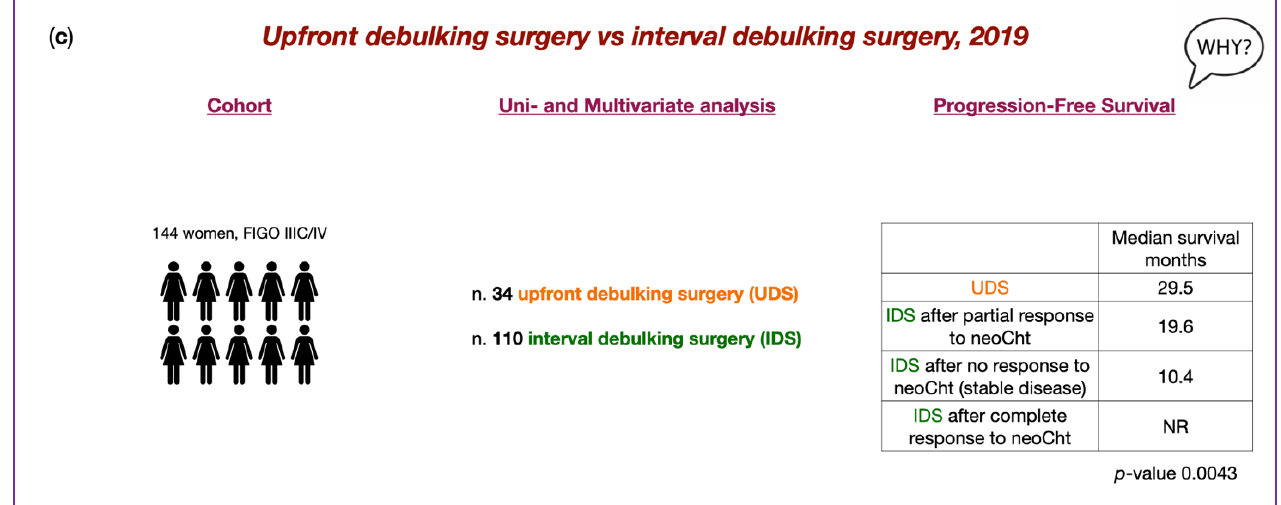
Figure 4. Italian PSM Oncoteam evidence. ( a ) Cavaliere et al. “1st Evidence− based Italian consensus conference on cytoreductive surgery and hyperthermic intraperitoneal chemotherapy for peritoneal carcinosis from ovarian cancer”. This image is licensed under the STM Guidelines http://www.stm-assoc.org/copyright-legal-affairs/permissions/permissions-guidelines/ (accessed on 16 May 2022). Reproduced with permission from Cavaliere D. (2017). ( b ) Di Giorgio et al. “Cytoreduction (Peritonectomy Procedures) Combined with Hyperthermic Intraperitoneal Chemotherapy (HIPEC) in Advanced Ovarian Cancer: Retrospective Italian Multicenter Observational Study of 511 Cases”.